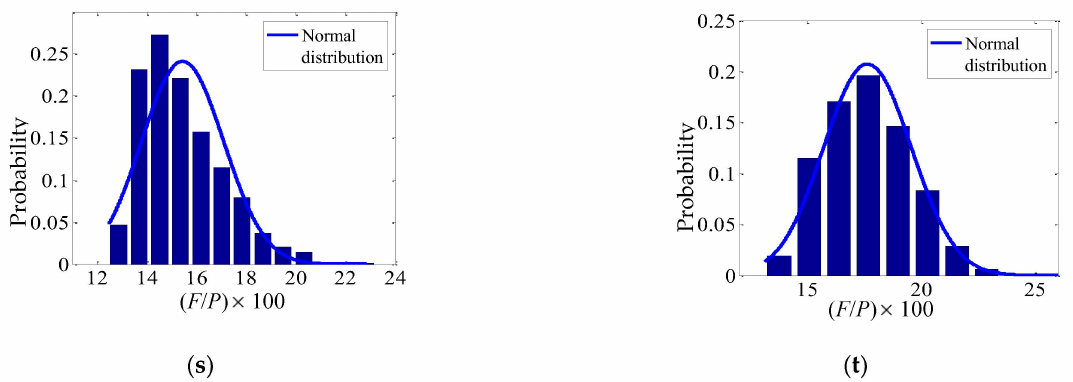
Figure 9. Probability density figures for F/P under the most unfavorable horizontal load combination.